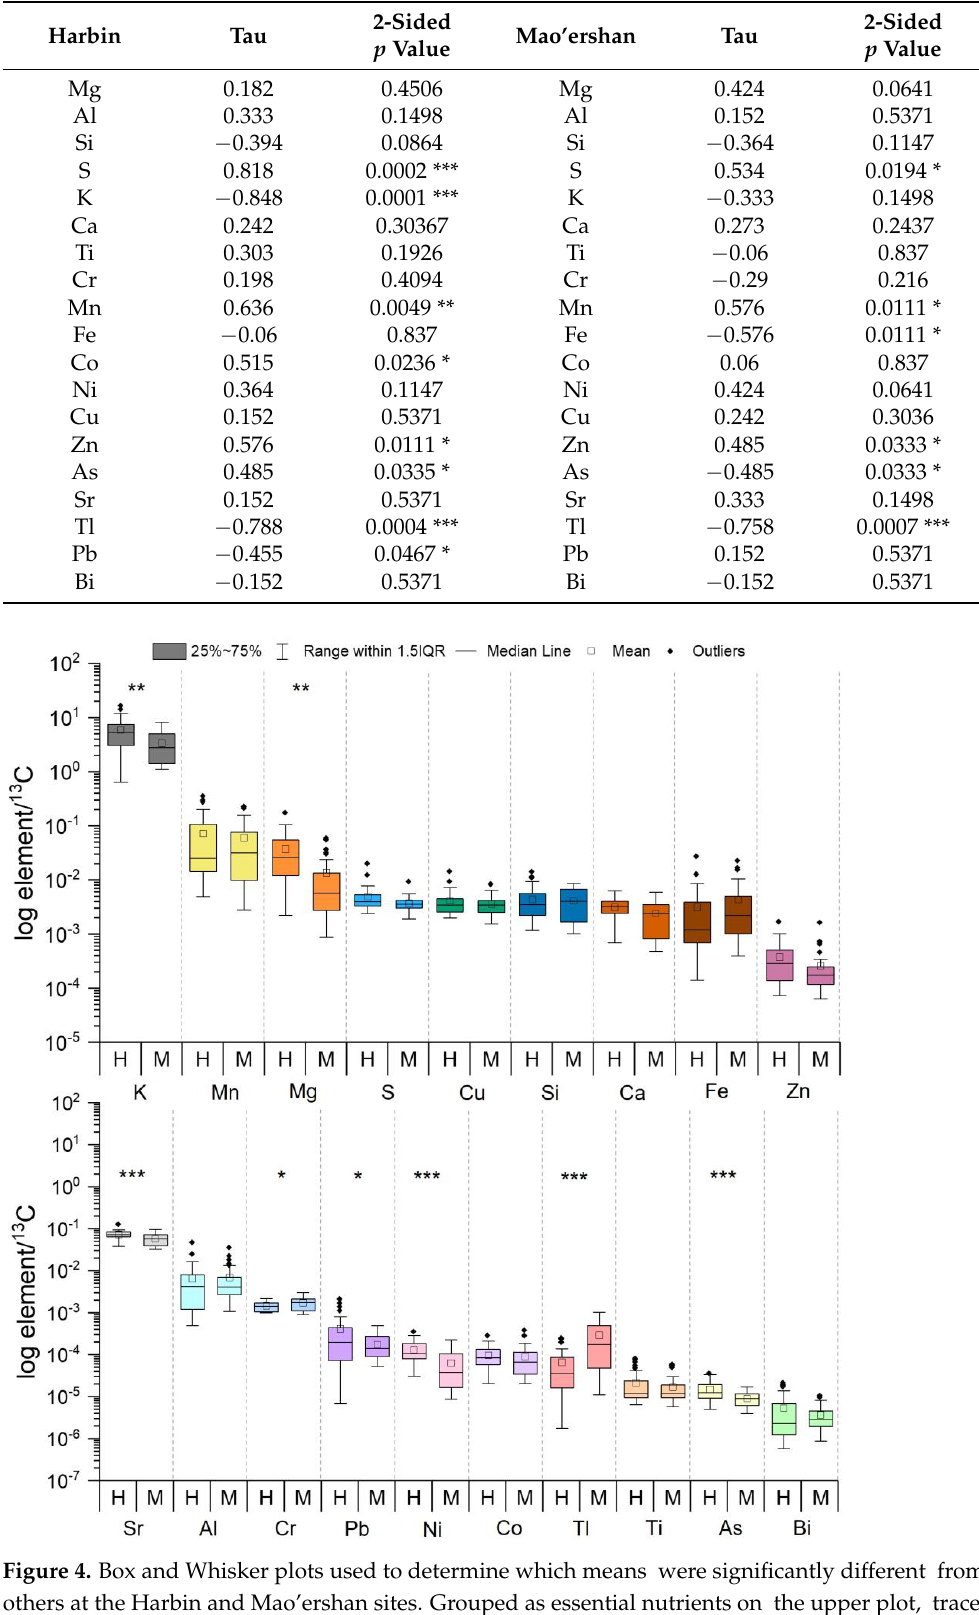
Table 3. Mann–Kendall rank correlation test of chemical elements in Harbin and Mao’ershan. Positive Tau values indicate positive trends, while negative Tau values indicate negative trends. For the p values: “*” p < 0.05, “**” p < 0.01, “***” p < 0.001.